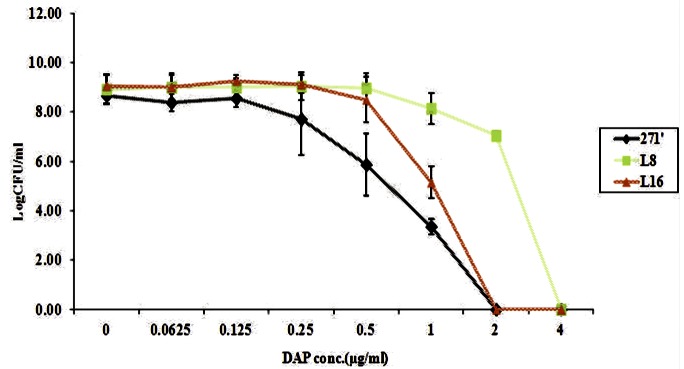
DAP population analysis of the parental vs two animal passage strains.